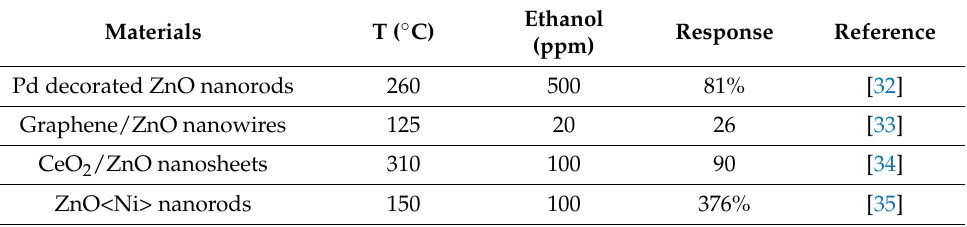
Table 2. Performance comparison of the ethanol sensors based on ZnO